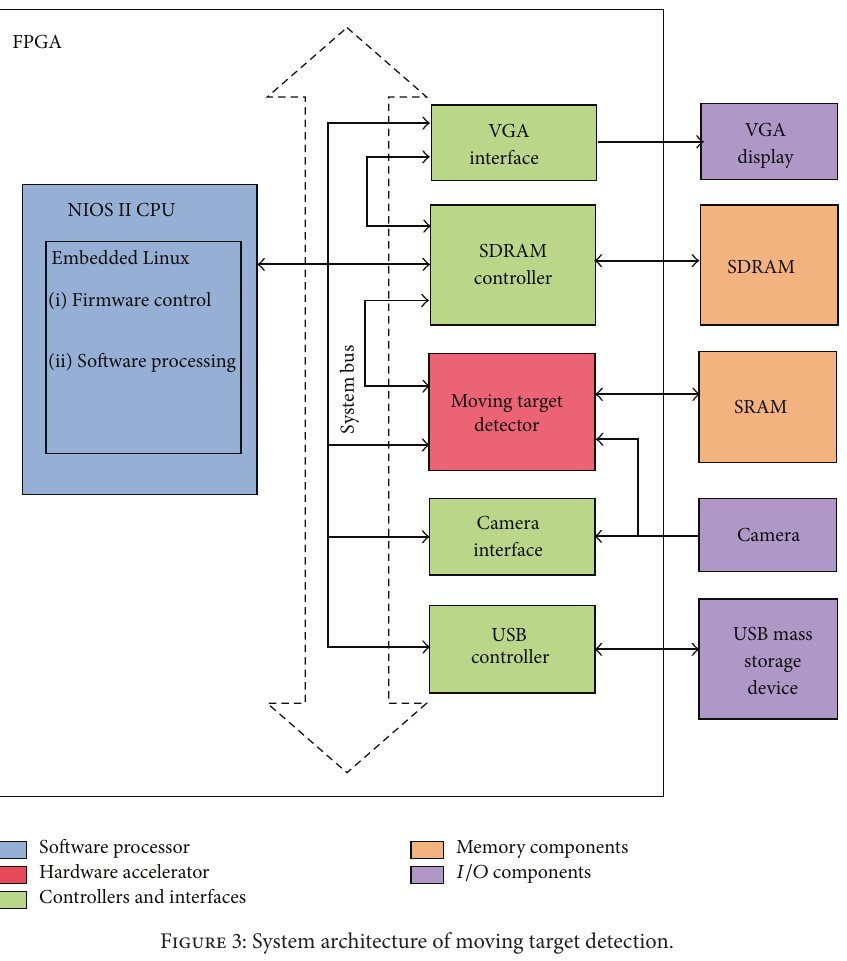
Figure 3: System architecture of moving target detection.